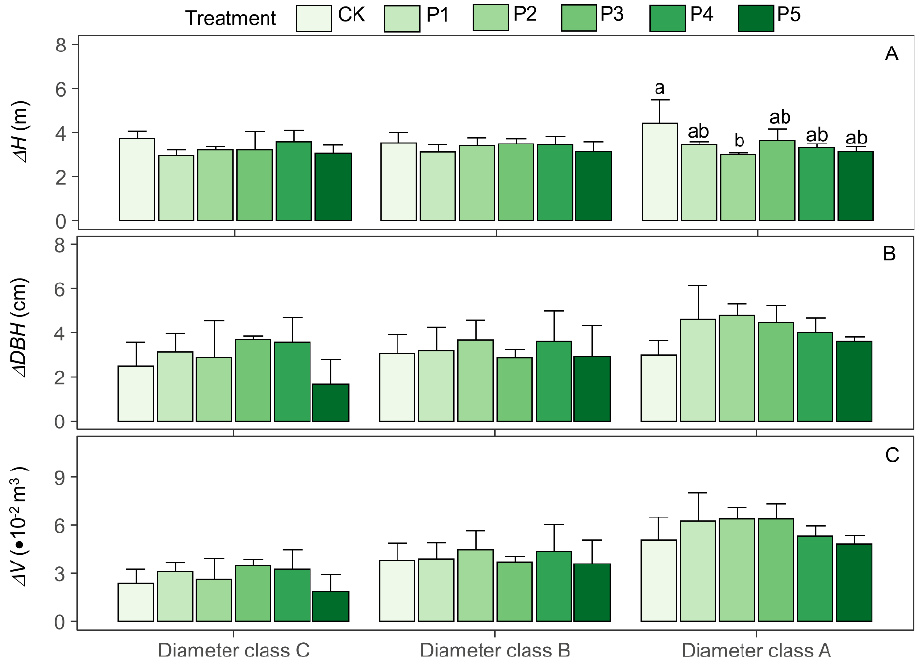
Figure 3. Growth differences between P. massoniana plantations under different treatments. The gradations of green from light to dark represent treatments CK, P1, P2, P3, P4 and P5, respectively. In panels ( A – C ), ∆ H , ∆ DBH and ∆ V represent the growth in height, diameter at breast height and individual volume from March 2019 to December 2021, respectively. Error bars represent standard deviation. Lowercase letters in the figure indicate the significant difference between treatments ( p < 0.05).